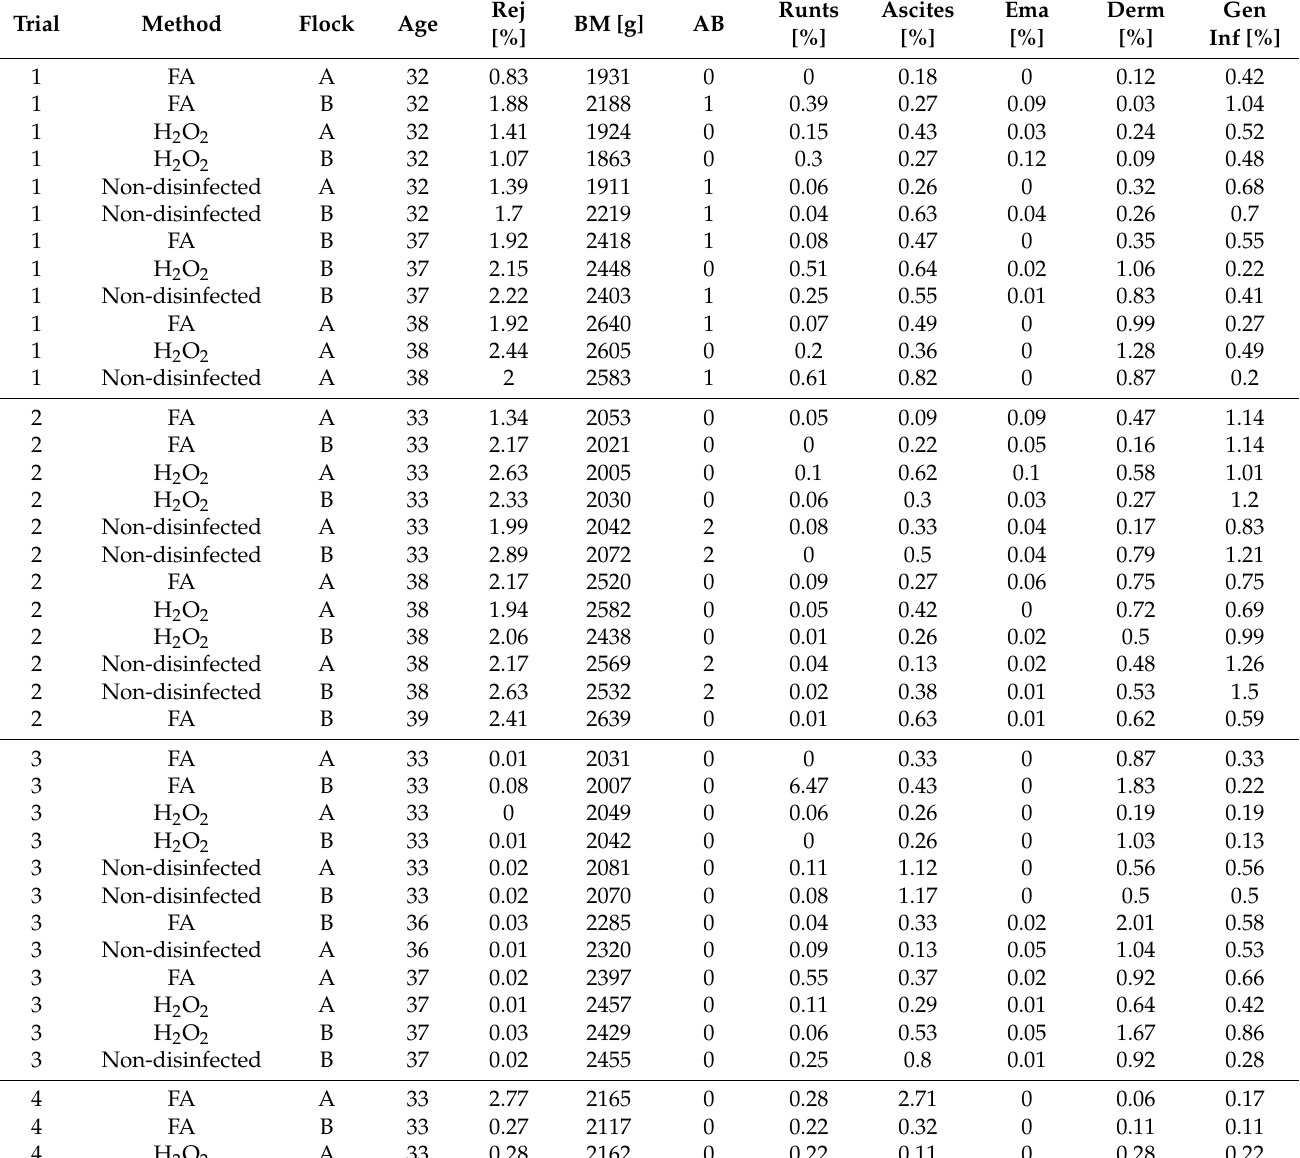
Table 2. Results from the slaughterhouse. Presentation of the amount of rejected carcasses (Rej), mean body mass (BM), and the number of anomalies like runts, ascites, emaciated animals (Ema), deep dermatitis (Derm) and general infection (Gen Inf) for trials 1 to 4. The use of antibiotic treatment (AB) is shown with 1 meaning antibiotics were applied and 0 meaning no antibiotics were